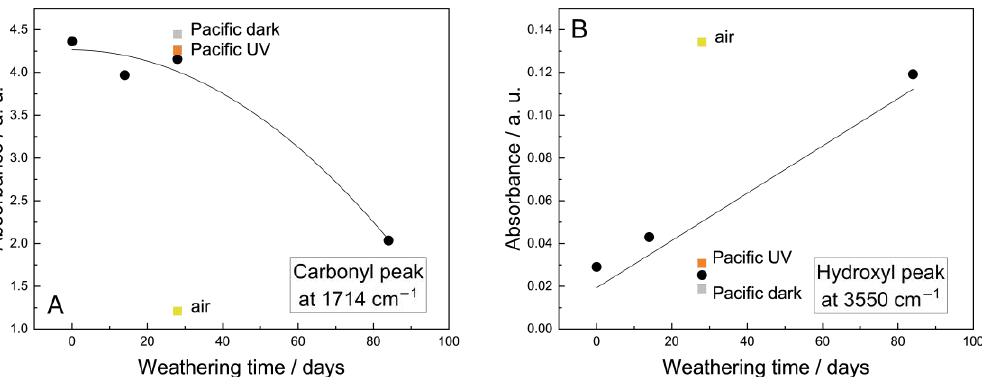
Figure 9. Change in functional group intensities (FTIR) over the course of artificial weathering in SAS (black dots with fit curve): decrease in the carbonyl peak at a wave number of 1714 cm −1 ( A ) and increase in the hydroxyl peak at 3550 cm −1 ( B ). In addition, the 28-day air-weathered sample and the 28-day Pacific-weathered samples are plotted.